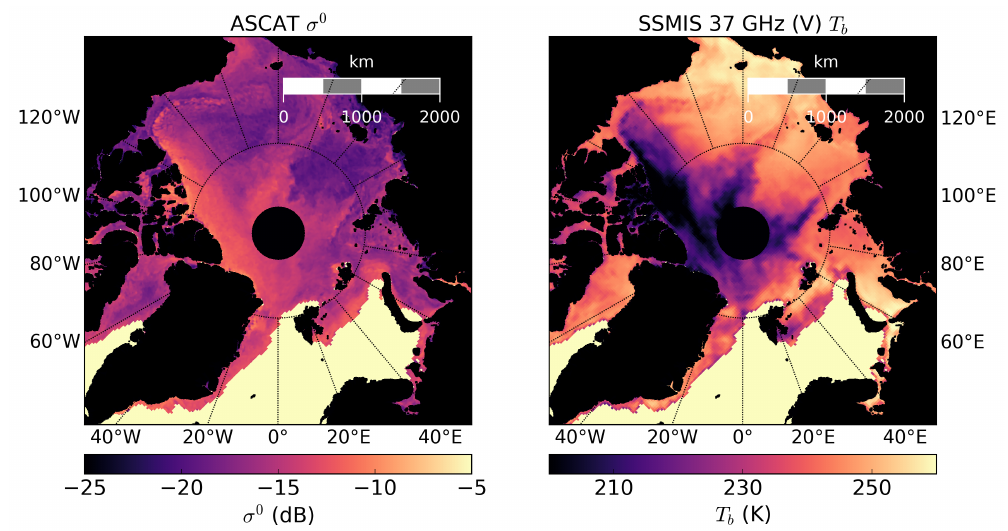
Figure 2. Example images of ASCAT σ 0 values and brightness temperatures for day of year 61, 2011 from the 37 GHz (V) channel of SSMIS over the Arctic. Areas of open water and land are masked as light yellow or black, respectively. The areas of MY ice correspond generally to the areas of high σ 0 values and low brightness temperature ( T b )